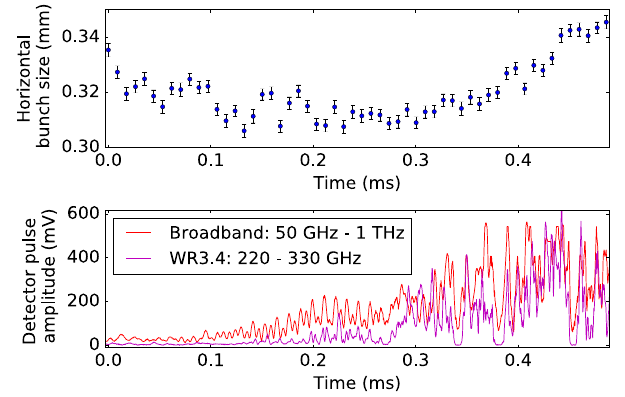
9. Horizontal bunch size recorded with a gate separation of 24 turns (top) and the corresponding CSR intensity (bottom) sampled with two Schottky diodes with different bandwidths. The error bars for the spot size are large compared to the ones in Fig. 8 due to the lower amplification of the microchannel plate leading to less counts on the CCD (raw data published in [[39], Fig. 3]). Beam parameter: f : 13.4 kHz, V : 1500 kV, s RF I : 1.57 bunch